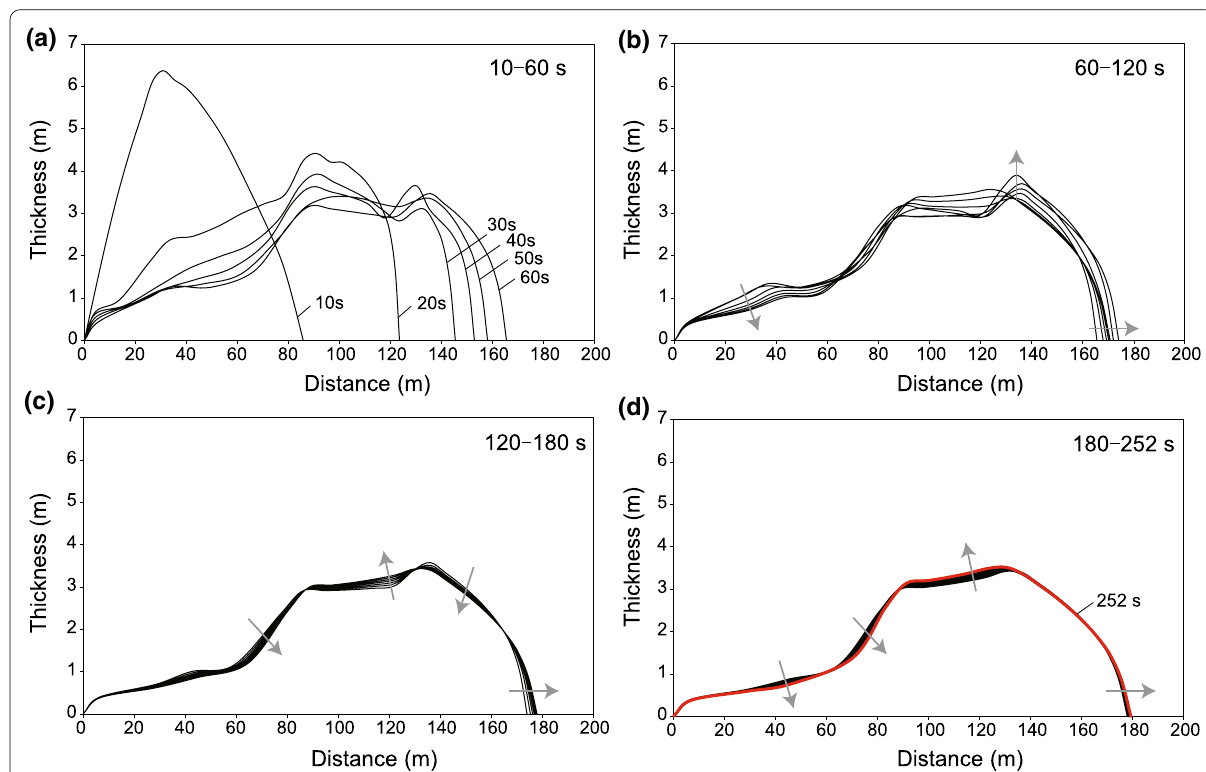
Fig. 7 Profiles of the modeled debris flow during the intervals from a 10 to 60 s, b 60 to 120 s, c 120 to 180 s, and d 180 to 252 s. The profiles were calculated using the optimized high-viscosity parameter set ( τ y debris surface with time. The final deposit geometry is indicated by the red profile in